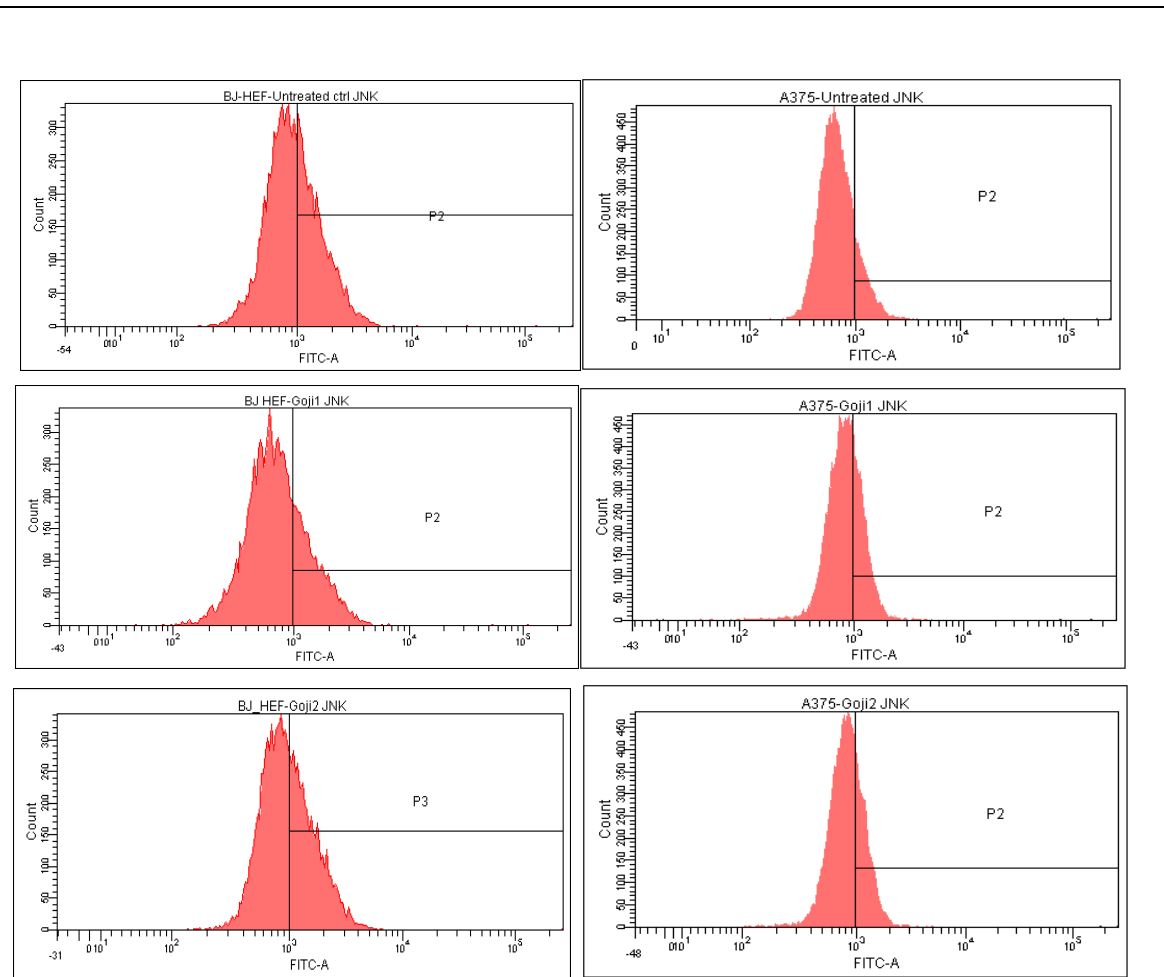
Figure 6. The intracellular c-Jun N-terminal kinases (JNK) modulation in normal BJ fibroblasts versus malignant melanoma A375 cells following the 24-h exposure to zeaxanthin. In the left column, the BJ cells are represented, while in the right column the A375 cells; from top down: cells without treatment (reference), cells treated with 1 and 2 .